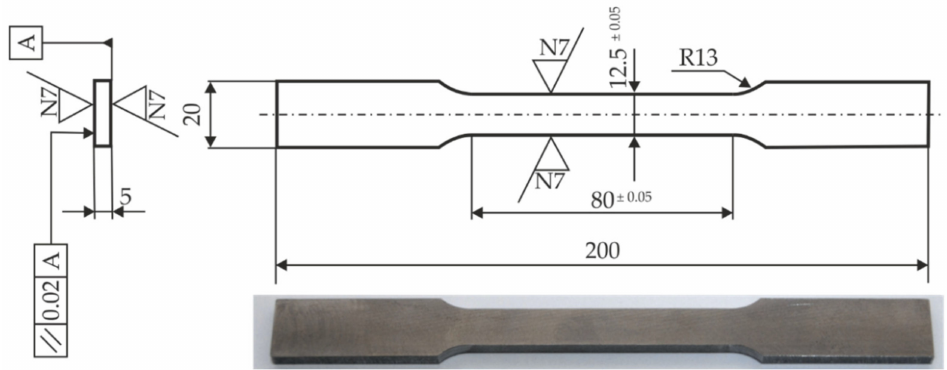
Figure 1. Technical drawing of testing specimen and real specimen (unit: